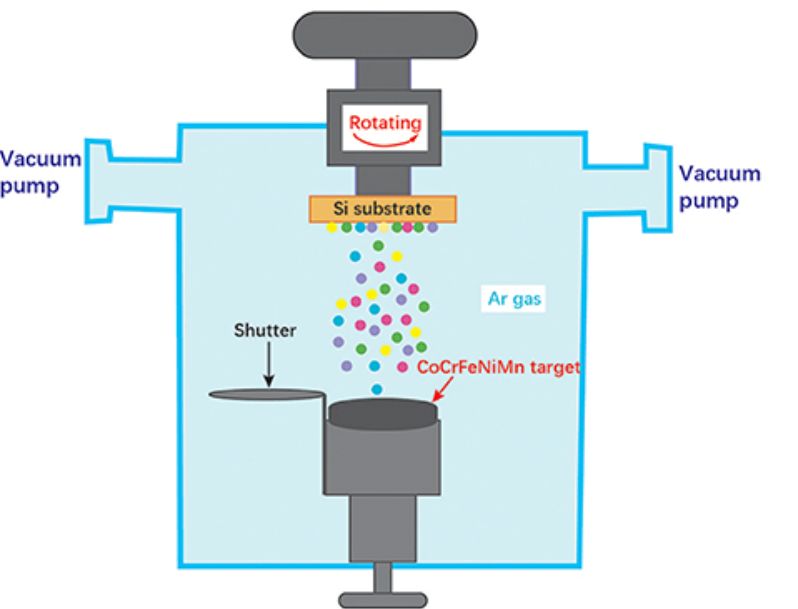
Figure 15. A schematic of multi-target magnetron sputtering for CoCrFeNiMn thin film on substrate. Reprinted with permission from [154] Copyright 2020 Elsevier.